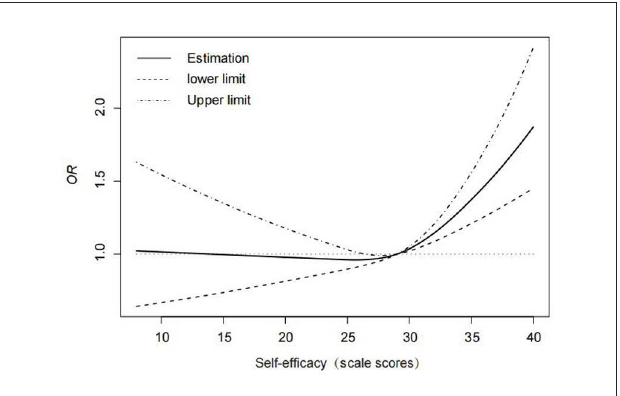
FIGURE2 Trends in the influence of family health on